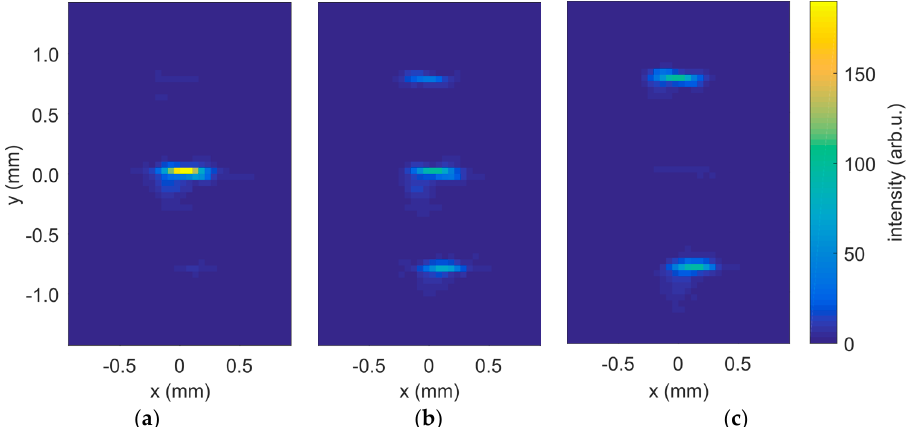
Figure 5. Irradiance distribution of the laser diode in the focal plane after reflection from the SDU for three different phase delays: ( a ) 0 , ( b ) π/2 , ( c ) π . The foci have line shapes because the laser had a 1.5 × 7 mm 2 rectangular aperture to match the beam size with the structured area of the SDU.